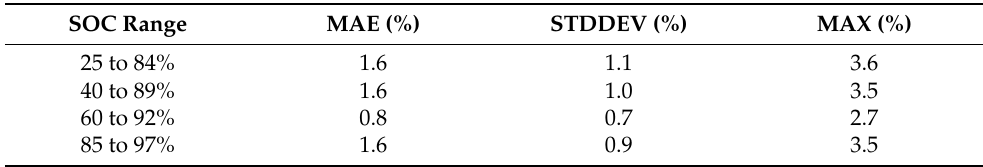
Table 5. SOH estimation error for different input SOC ranges. The stated ranges are for the battery when it was new.